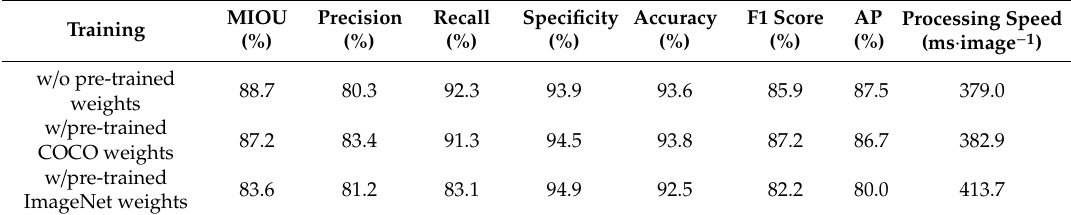
Table 4. Performance of the detectors trained with various pre-trained weights.